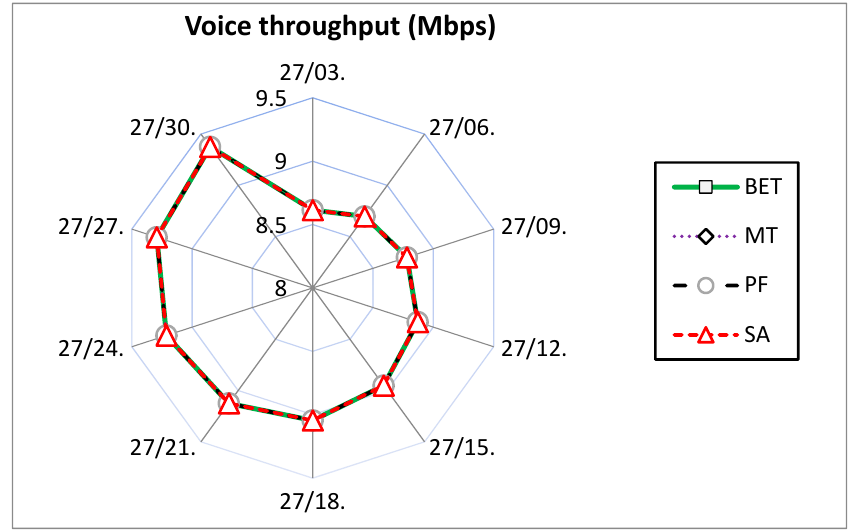
Figure 6. Uplink cell throughput for voice users in mixed traffic.